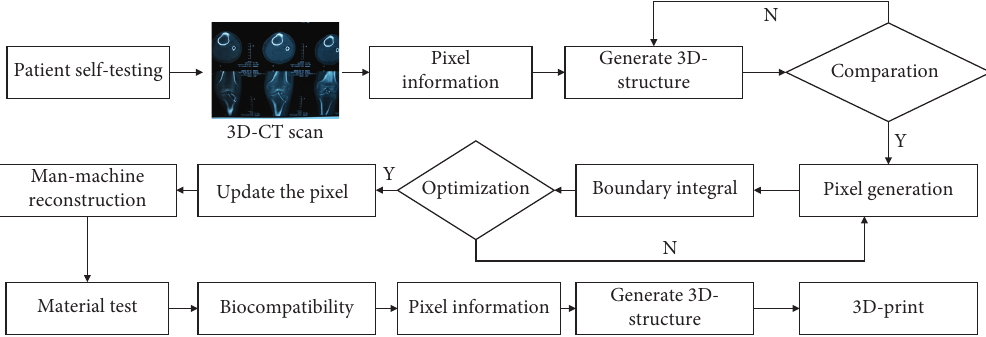
Figure 6: Analytical framework of application of 3.0 T MRI to knee joint sports injury assessment and exercise rehabilitation. Table 2: Assessing grade results of knee joint sports injuries of patients in the 3.0 T MRI group ( n